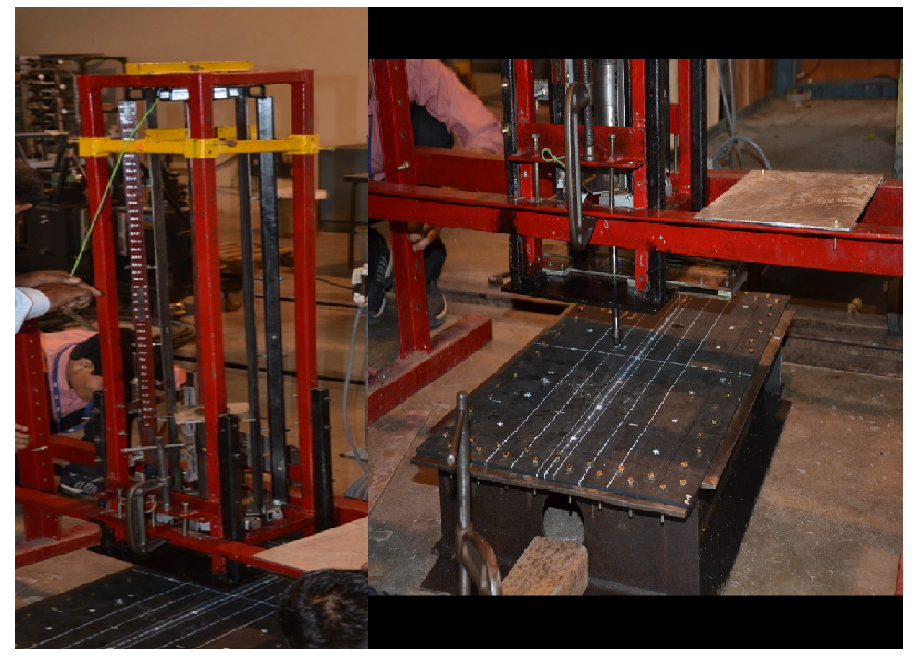
Figure 10. Drop weight impact tower.